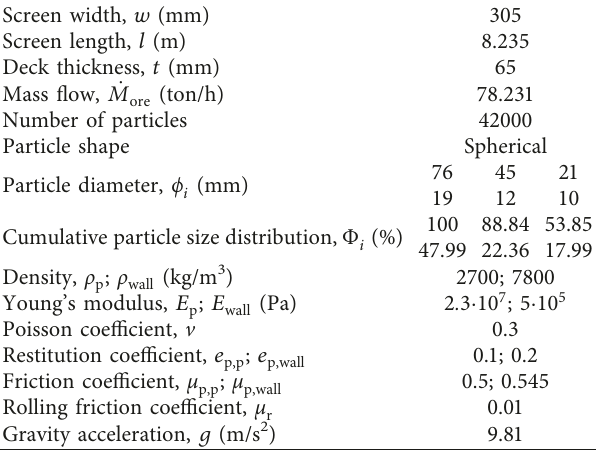
Figure 4: Geometry of the vibrating screen (a) CAD model showing the (1) upper deck, (2) lower deck, (3) feed chute, (4) rear wall, (5) lateral wall; (b) upper screen deck module; (c) lower screen deck module. Table 1: Parameters used for the DEM simulations.